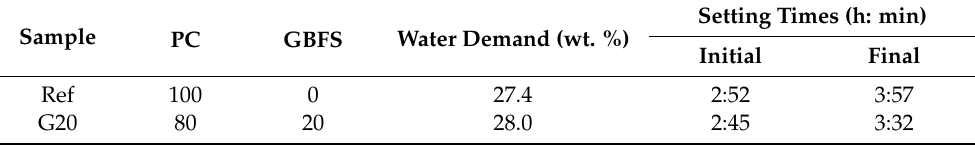
Figure 2. XRD result of GBFS. Table 2. Mix proportion (wt. %) and physical properties of GBFS blended cement. Sample